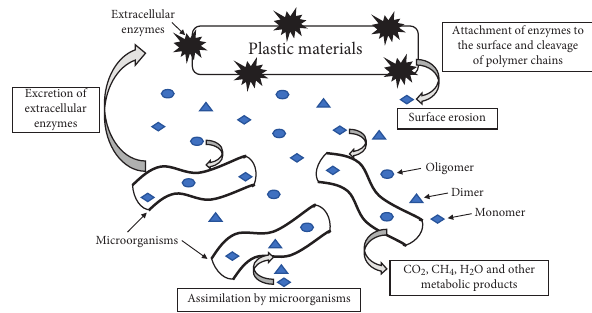
Figure 4: Mechanism of plastic biodegradation